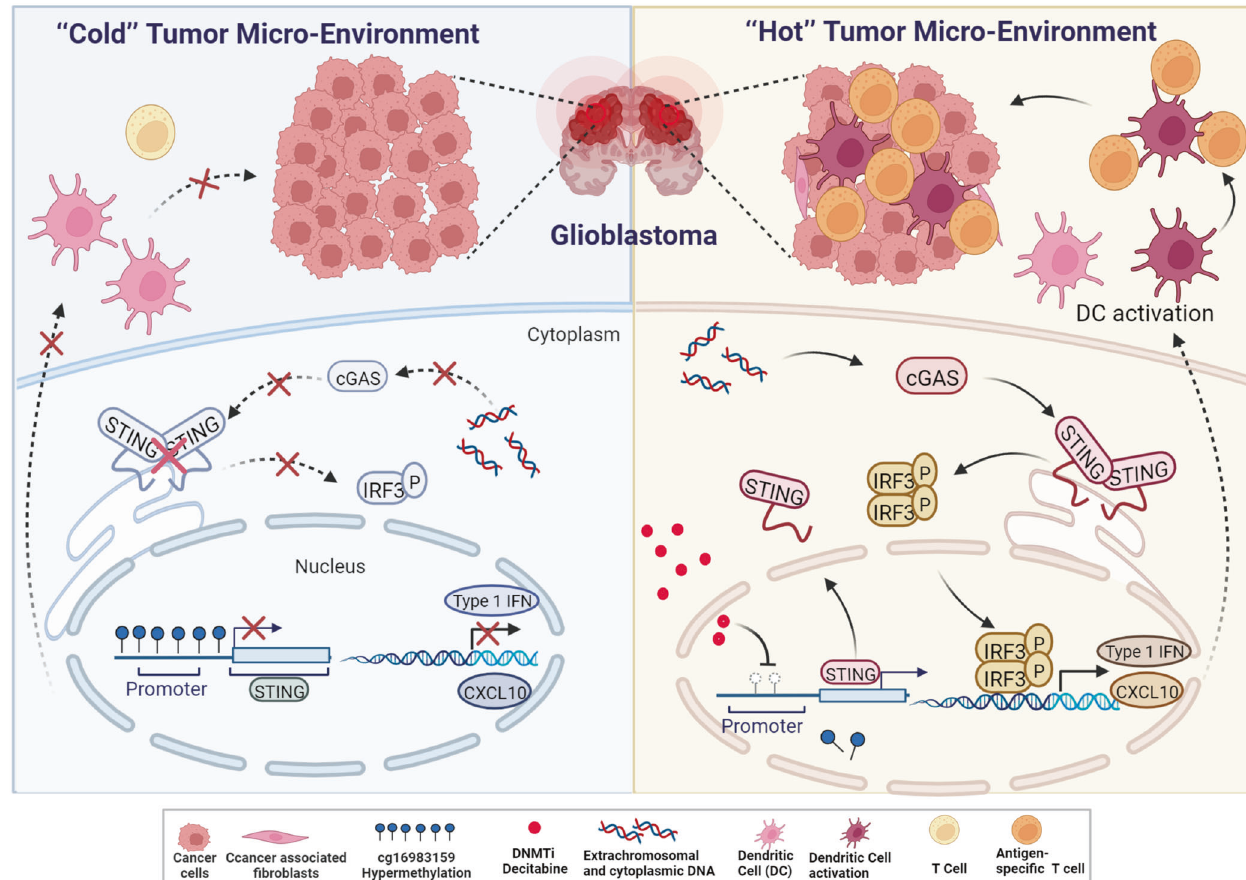
Fig. 1 Schematic diagram demonstrating the epigenetic mechanism regulating glioblastoma tumor micro-environment. Left, in glioblastoma, cg16983159 of STING promoter is hypermethylated, silencing the cGAS – STING signaling pathway, suppressing the expression of Type I IFN and CXCL10, thus leading to the “ cold ” tumor micro-environment. Right, when treated with DNMTi decitabine, cg16983159 of STING promoter is demethylated, turning on STING expression and cGAS – STING signaling, sensitizing GBM cells to immunotherapies. The fi gure is created with